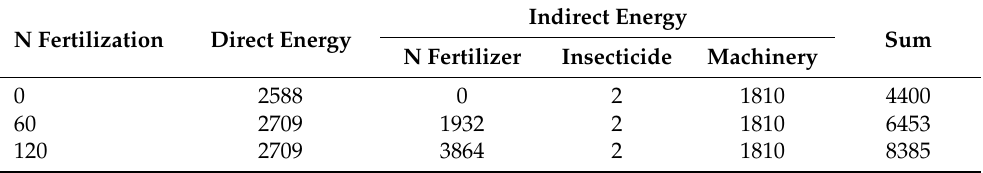
Table 4. Direct and indirect energy input (MJ ha − 1 ) for oat:peat intercrops as affected by N fertilization. N